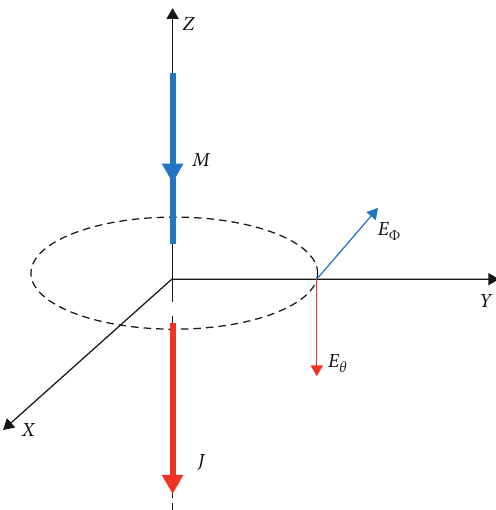
Figure 1: Equivalent model from the view of the proposed